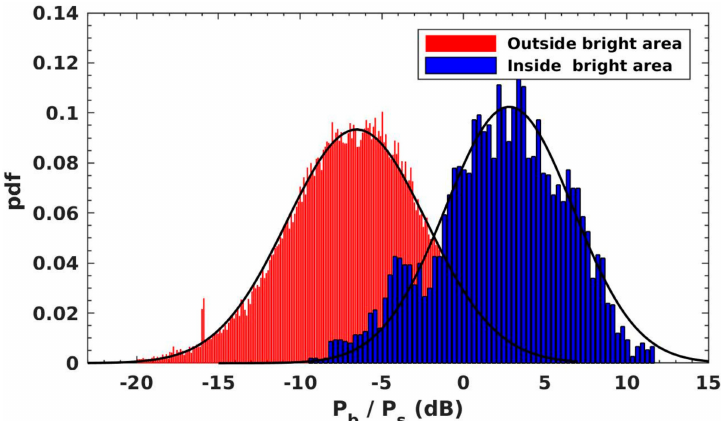
Figure 5. Distributions of the power ratio P b / P s for the data collected inside (blue) and outside (red) the bright area. Black lines are the computed normal pdfs for the two areas.